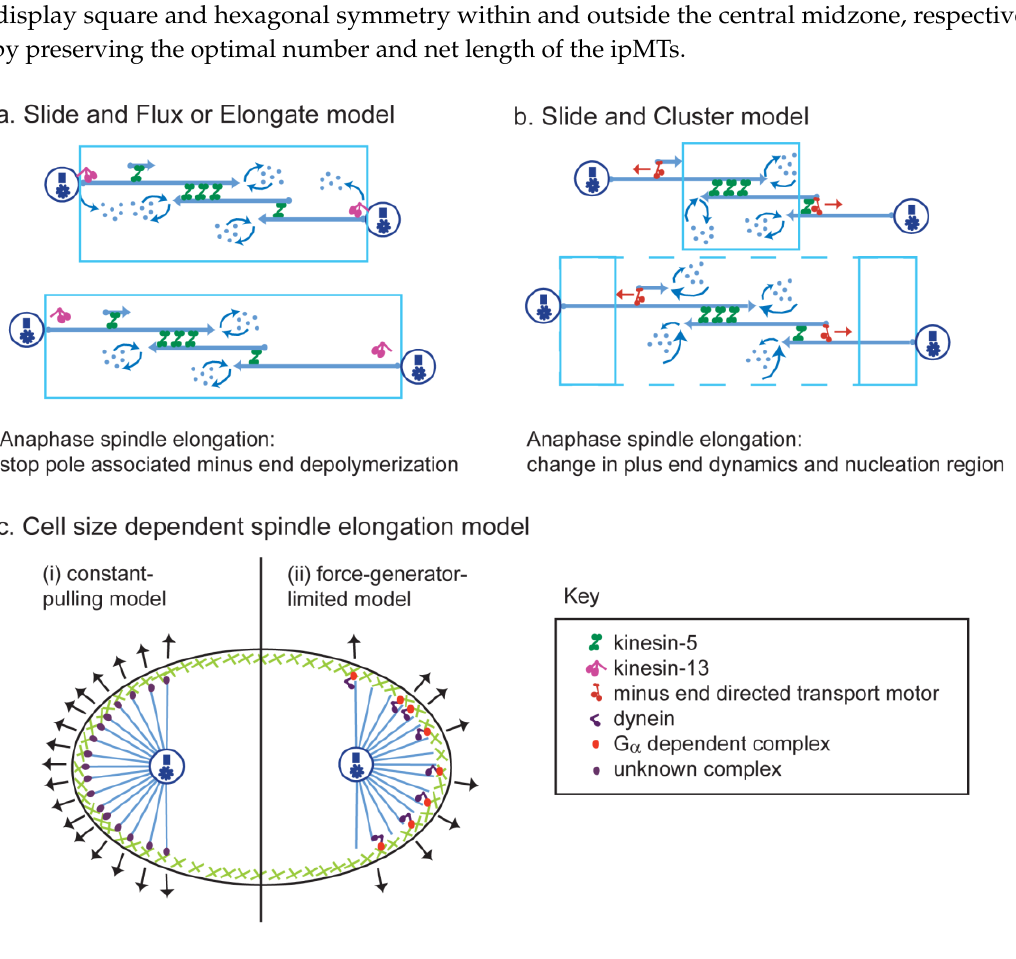
Figure 7. Theoretical models of anaphase B. Three of the models discussed in the text are drawn here, namely ( a ) the slide and flux-or-elongate (SAFE) model; ( b ) the slide-and-cluster (SAC) model; and ( c ) the cell-size dependent spindle elongation model. (( a ) and ( b ) are based on [199] and ( c ) is based on [192].)